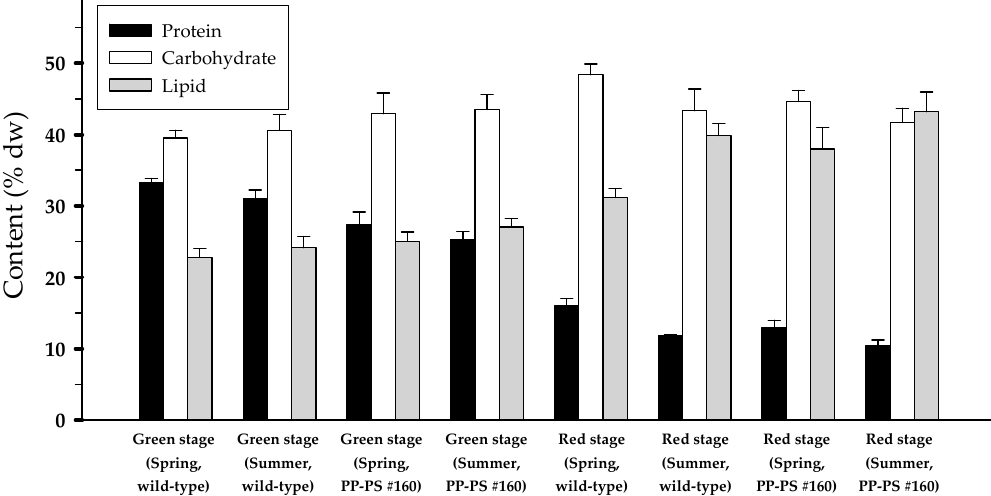
Figure 5. Comparison of the contents of protein, carbohydrate, and lipid from H. pluvialis cells of wild type and the mutant PP-PS 160 at the end of each stage of green and red during spring and summer conditions. Each value is mean ± standard deviation of three replicates.